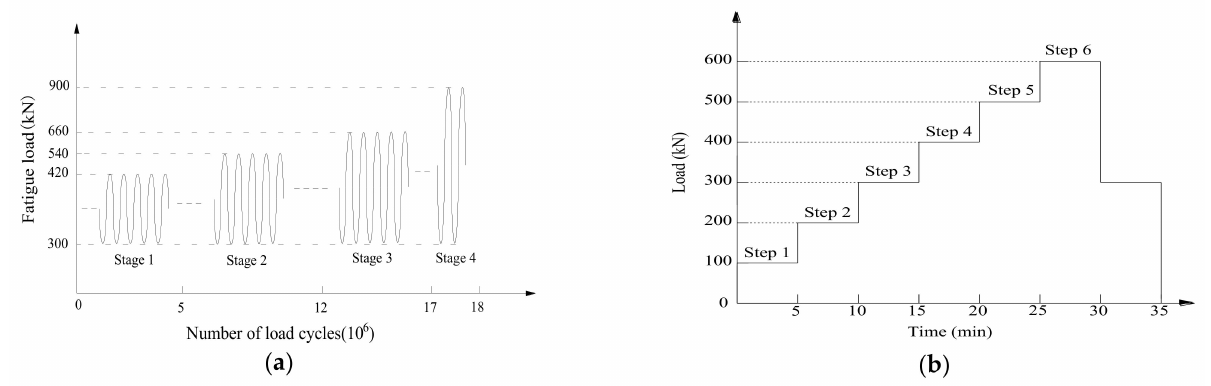
Figure 3. The loading scheme: ( a ) Fatigue dynamic test; ( b ) static load